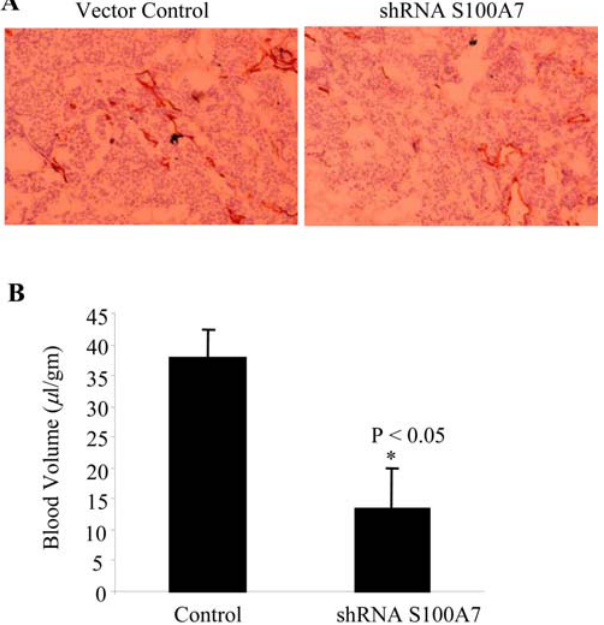
Figure 4. S100A7-downregulation decreases angiogenesis. (A) Effect of S100A7 on blood vessel formation in matrigel plugs containing MDA-MB-468 cell lines. 250 m l of Growth factor-reduced Matrigel Matrix High Concentration (BD Biosciences) was mixed with 6 6 10 6 cells (250 m l of vector control or 250 m l of S100A7-downregulated cells) and implanted subcutaneously into SCID mice (two sites per mouse). After 4 weeks, one matrigel plug from each mouse injected with vector control or S100A7-shRNA cells was fixed in Tissue Tek and snap-frozen. The sections were stained for CD31 antibody by immunohistochemistry. (B) The other plug was grounded and the supernatant was analyzed for hemoglobin content using the Hemoglobin Assay Kit (Sigma Diagnos- tics). The results are interpreted as the blood volume per unit weight of matrigel (* p , 0.05).